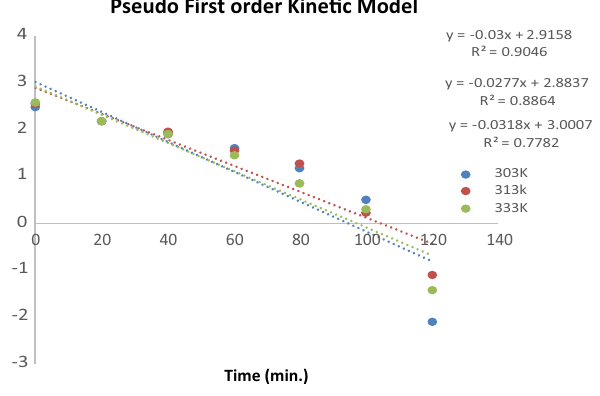
Fig. 17 Pseudo-first-order kinetic model. Temperature—30, 40, 60 °C, concentration—20 ppm, time—180 min, rpm—100, adsorbent dose—150 mg, volume—100 ml